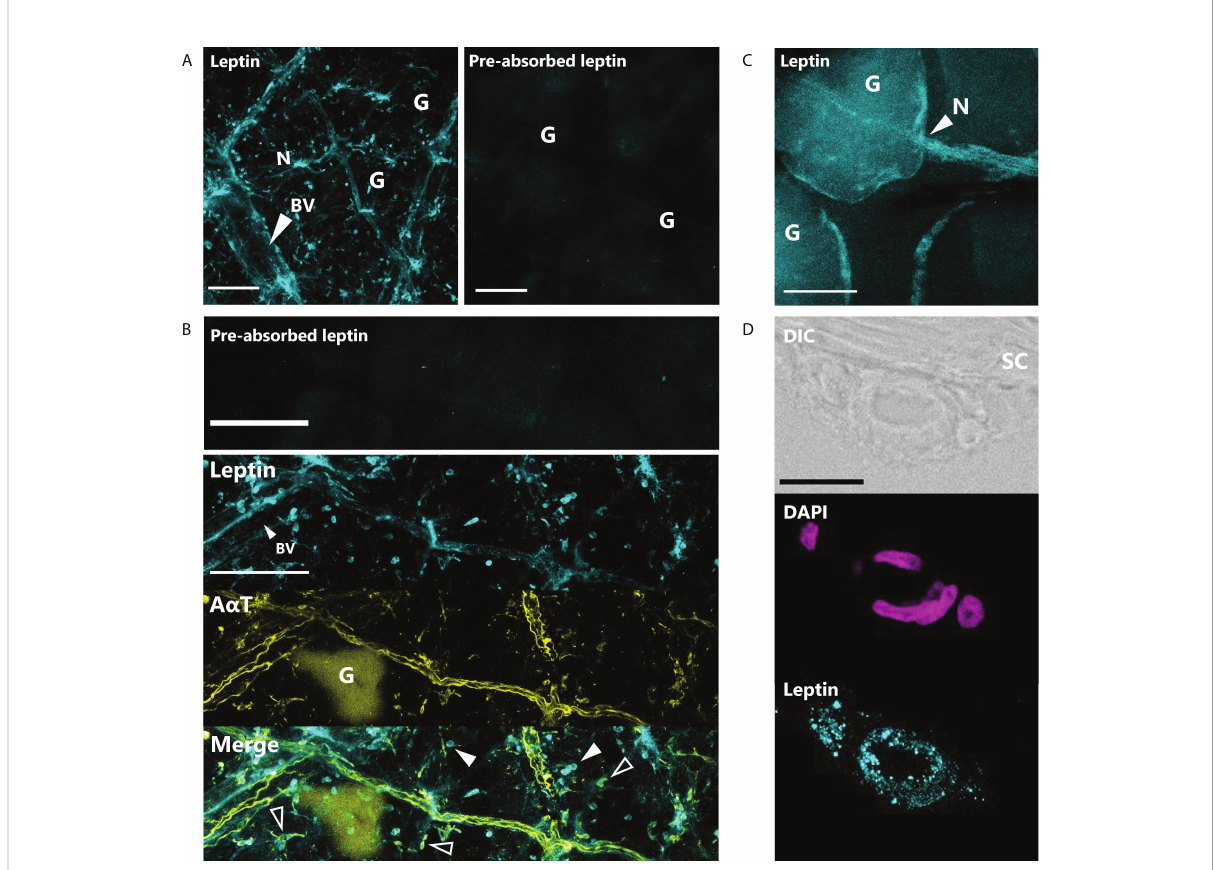
FIGURE 1 Leptin is expressed in nerves and blood vessels in the dorsal skin of Xenopus laevis juveniles. (A) Leptin protein is expressed in blood vessels (BV) and nerves (N) in the dermis and hypodermis. Only background fl uorescence from granular glands (G) is present in tissue stained with antibody that was incubated with recombinant Xenopus leptin protein (4 m g) prior to staining (pre-absorbed). Scale bars, 100 µm. (B) Leptin is expressed in the endothelial cells of a large blood vessel (BV) in the hypodermis and unknown scattered cell bodies (solid arrows). Leptin also co-localizes with acetylated alpha-tubulin (A a T, yellow), a neural marker in axons and some nerve cell bodies (hollow arrows). Granular glands are auto fl uorescent after bleaching and clearing at 488 nm (as seen in the A a T panel). Scale bars, 100 µm. (C) Leptin protein co-localizes with axons innervating a granular gland. (D) Cross section showing leptin in the endothelial cells of a blood vessel in the hypodermis, up against the stratum corneum (SC) of the dermis. Scale bar, 25